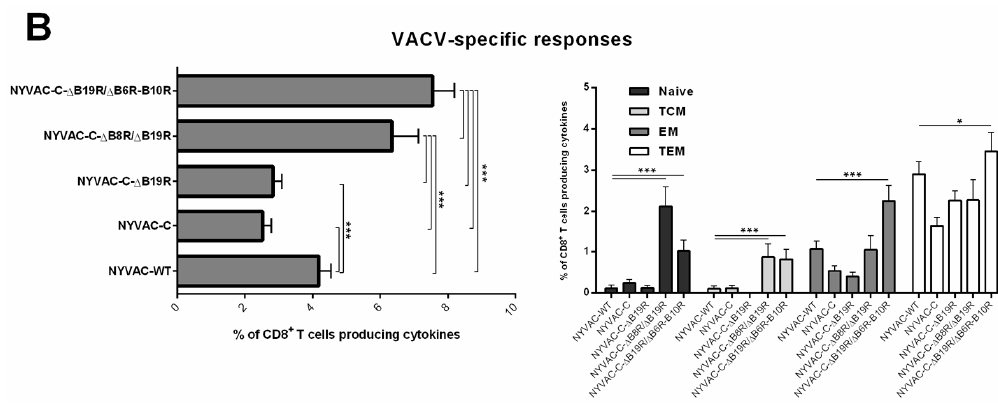
Figure 4. Cellular immune response elicited by NYVAC-C recombinant after combined deletion of various unknown non-essential genes with VACV-IFN and cytokine inhibitors. Magnitude and phenotypic profiles of ( A ) memory HIV-1-specific CD4 + (top) and CD8 + (bottom) T cells and ( B ) memory VACV-specific CD8 + T cells. The vaccine-induced cellular immune response was characterized by multi-parameter flow cytometry 53 days after the last immunization. Values indicate the sum of the percentages of T cells secreting IFN- γ and/or TNF- α and/or IL-2 against Env plus Gag plus GPN peptide pools (for HIV-1-specific responses) or E3 peptide (for VACV-specific responses). Background percentages were subtracted from all data. The phenotype of vaccine-induced memory responses was determined based on expression of CD44 and CD62L surface markers on activated T cells as in Figure 3. * p < 0.05; ** p < 0.005, *** p < 0.001. Significant differences compared to the NYVAC-C group (for HIV-1 response) are indicated above each column.